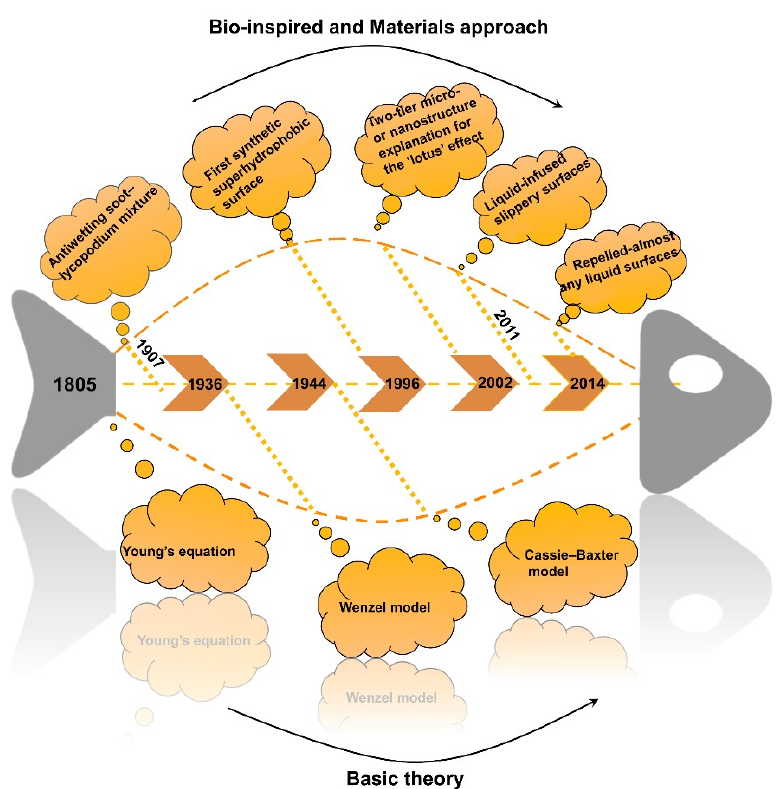
Figure 3. Chart of the major discoveries and developments in the field of superhydrophobic coat- ings